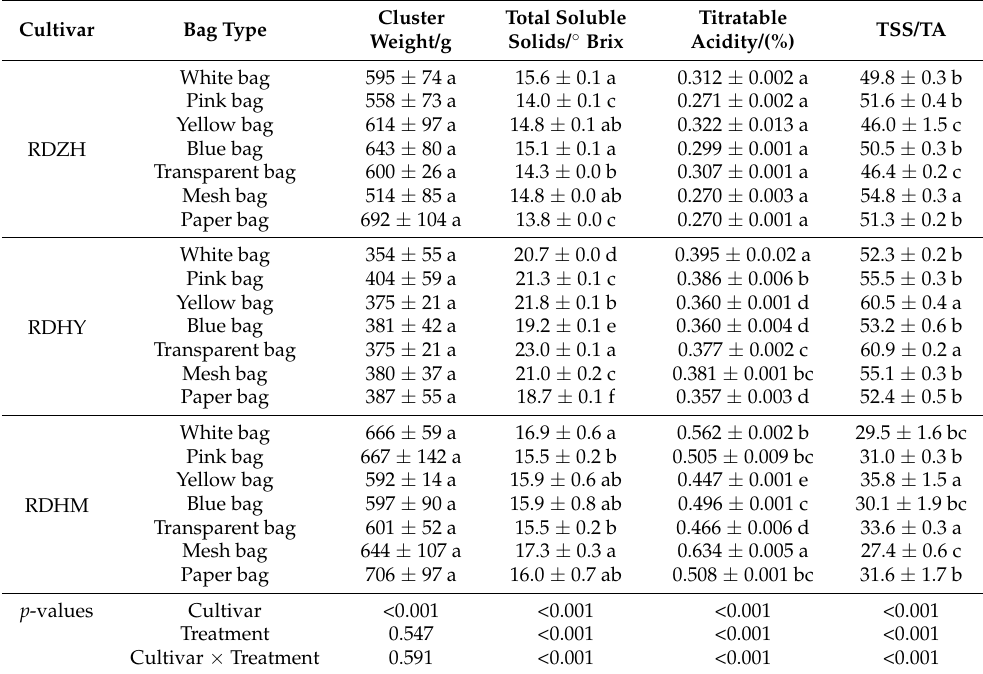
Table 1. Effects of fruit bagging treatment with different types of bags on the basic quality indicators of the three table grape